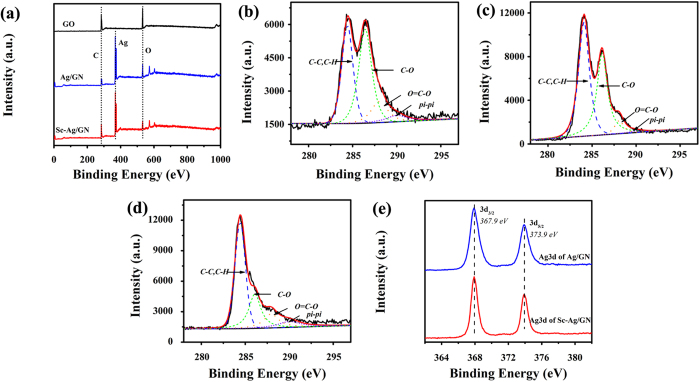
(a) XPS survey scans of GO, Ag/GN and Sc-Ag/GN; C1s XPS spectra of (b) GO, (c) Ag/GN, (d) Sc-Ag/GN; (e) High resolution Ag3d spectra of Ag/GN and Sc-Ag/GN.